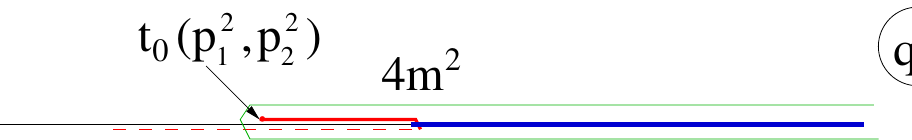
< 4 m 2 , < 4 m 2 , 0 < p 2 2 1 ( p 2 ) to 4 m 2 ) and , p 2 0 2 1